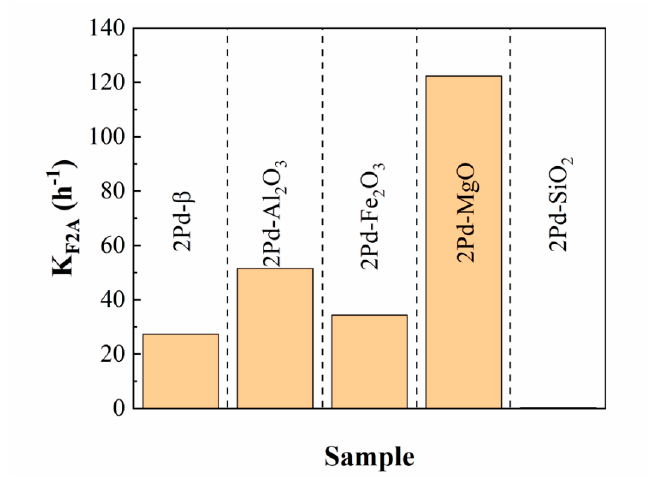
Figure 9. Kinetic constant of F2A formation (K F2A ) for Pd-based catalysts. Experimental conditions: temperature: 170 °C, time: 3 h, catalyst loading: 0.05 g, V (ethanol) : 6 mL, amount of base (Na 2 CO 3 ): 0.10 g, V (H 2 O 2 , 30 wt%): 0.5 mL.